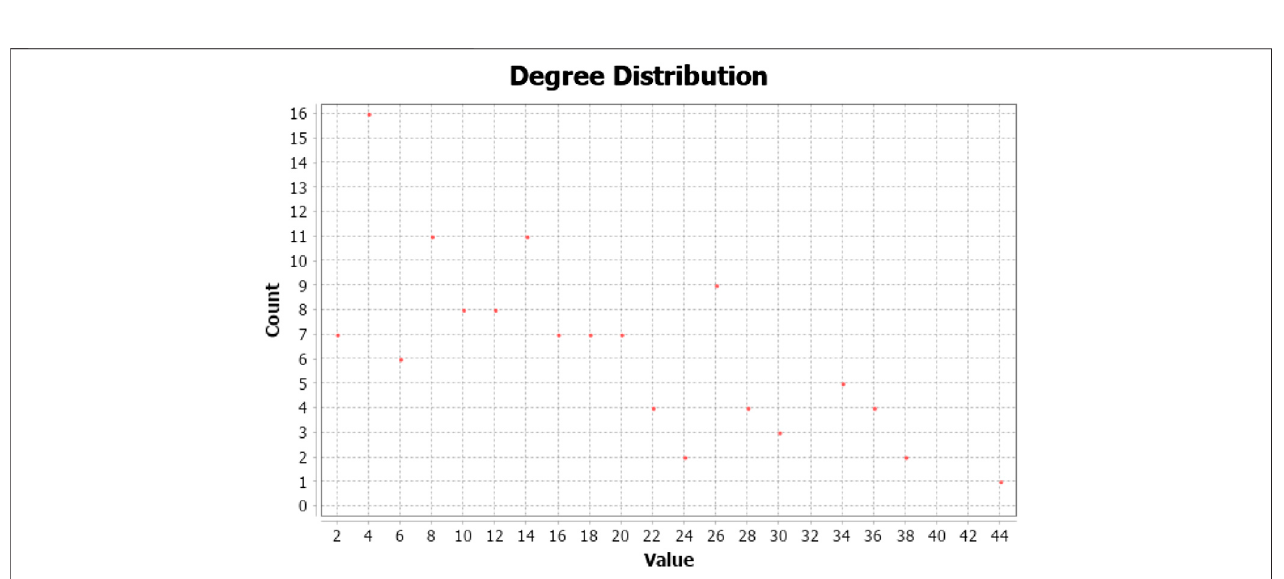
FIGURE 2 | The degree distribution of the global network. Note: Figure 2 represents the degree distribution. The vertical and horizontal axes of each subplot are node counts and parameter distribution values, respectively.The horizontal axis represents the degree value ofeach country.The vertical axis represents the number of countries. For example, value (cid:1) 2 and count (cid:1) 7 means that there are seven countries, and they all have a degree of two.